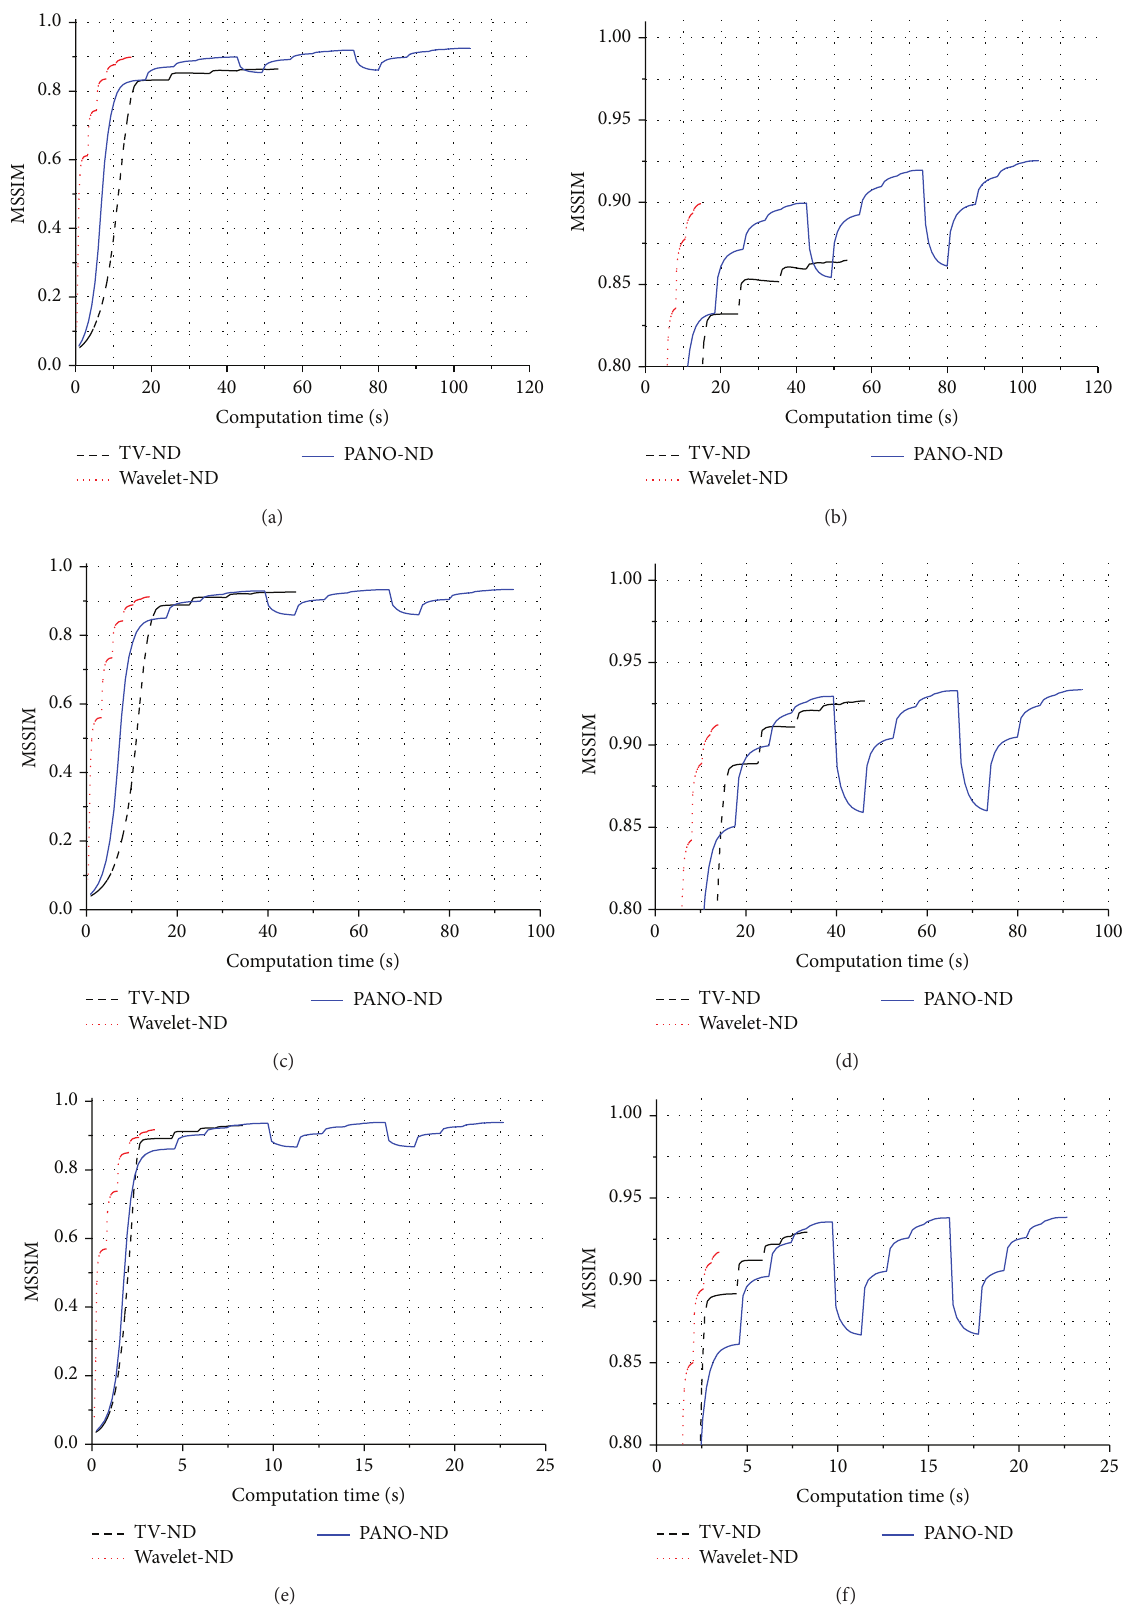
Figure 12: Figure 11 MSSIMs versus computation time from 50% salt and pepper noise. (a), (c), and (e) are MSSIMs for Barbara , Boat , and House images and (b), (d), and (f) are the zoom out part of (a), (c), and (e) when MSSIMs are greater than